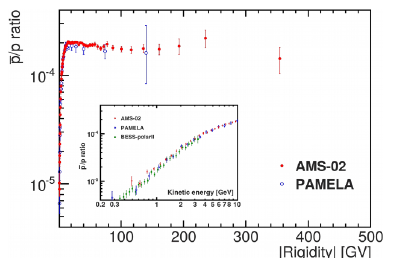
Figure 4. The ¯ p / p fl ux ratio as measured by AMS along with previous